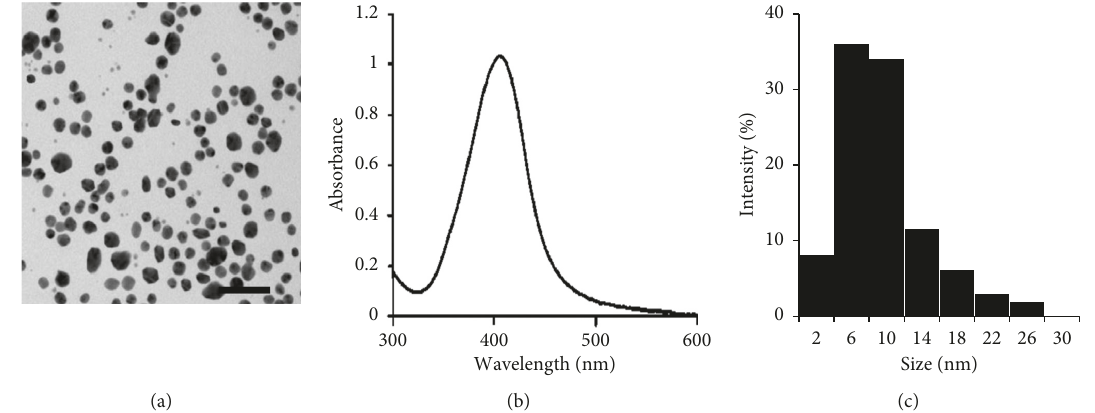
Figure 1: Morphology (a), absorbance wavelength (b), and size intensity (c) of silver nanoparticles (AgNPs) (scale bar: 50nm).